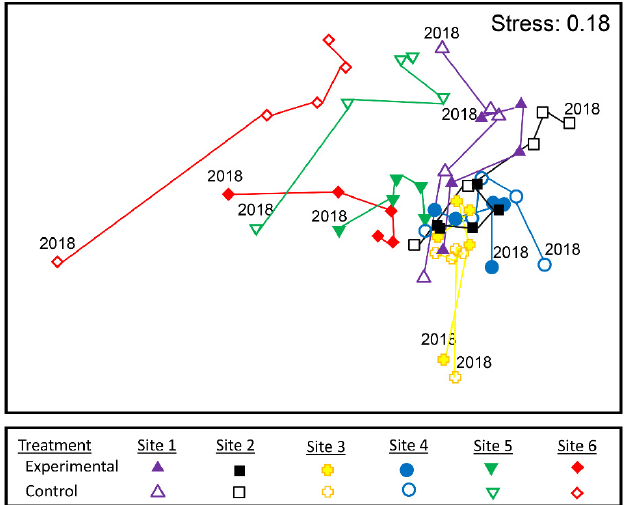
Figure 3. MDS ordination for all plots across the five sampling years (2018–2022) according to the composition and relative cover of plants in each plot. Experimental plots excluded herbivores while control plots allowed herbivores access. Lines connect samples from each plot across sequential years (2018 denotes the first year). Sites 5 and 6 were in small spot fires with intact CSS close to plots. The SIMPER test comparing which species drove differences between all control and experimental plots revealed that herbivores reduced native shrub and non-native grass and forb cover, while native forbs had elevated cover in the control plots (Table 1). Shrub species that typify later CSS successional stages had low cover across most sites and plots ( A. californica , averaging 1%; E. fasciculatum , < 1%; Salvia melifera , < 1%). The post hoc SIM- PER test revealed that comparing control (herbivore allowed plots) at sites in spot fires to those in the primary fire perimeter had significantly different assemblages (85.22% aver- age dissimilarity among spot fire and primary fire perimeter plots) (Table 2). In general, abundances of most species were reduced, except for the native forb Camissoniopsis spp and the native shrub A. californica . Increases in A. californica cover in control plots can be ex- plained by elevated recruitment and evidence of resprouting in the spot fires. Table 1. Results from SIMPER analyses listing the most important species that contribute to differ- ences in plant assemblages between experimental (herbivore excluded) and control (herbivore al- lowed) plots. Subscripts indicate a plant’s designation as either a native shrub (NS), native annual forb (NF), native perennial forb (NPF), non-native grass (NNG) , or non-native annual forb (NNF). Plant Taxa